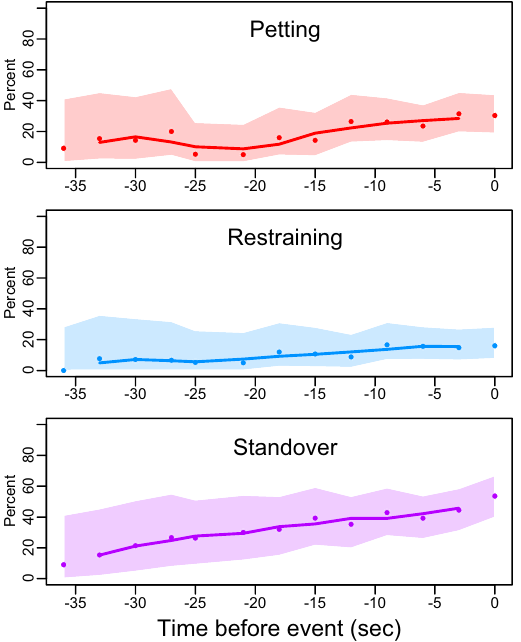
Figure 2. Patterns of changes in human behaviour (petting, restraining and standing over the dog) preceding the bite. Dots indicate observed proportions, clines represent 3-point moving averages and the shaded area the 95% confidence intervals for the